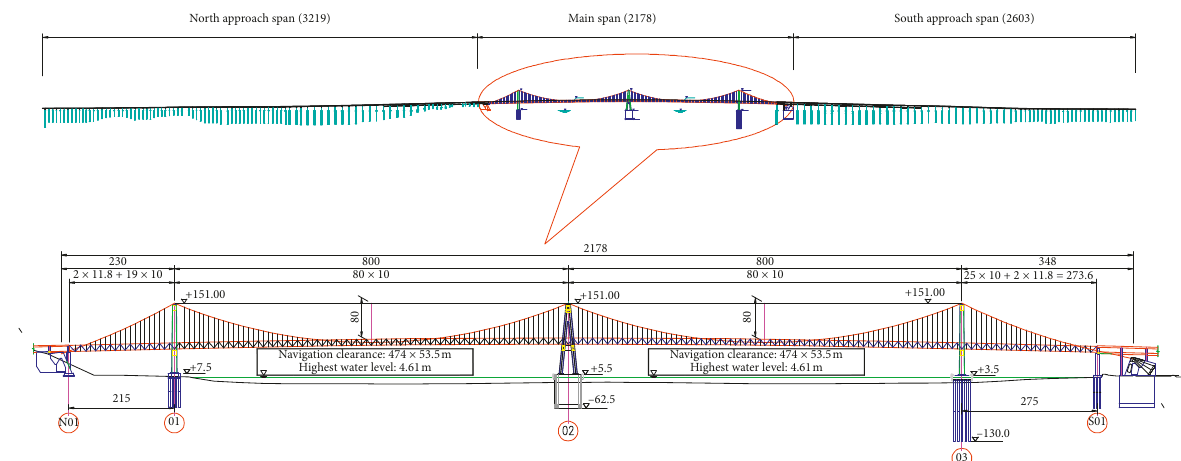
Figure 5: Ou River Estuary Bridge arrangement of main span and approach span (units: m).